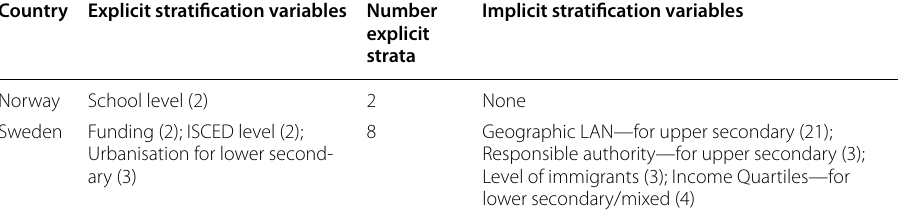
PISA 2018 Technical Report, Chapter 4, https:// www. oecd. org/ pisa/ data/ pisa2 018te chnic alrep ort/